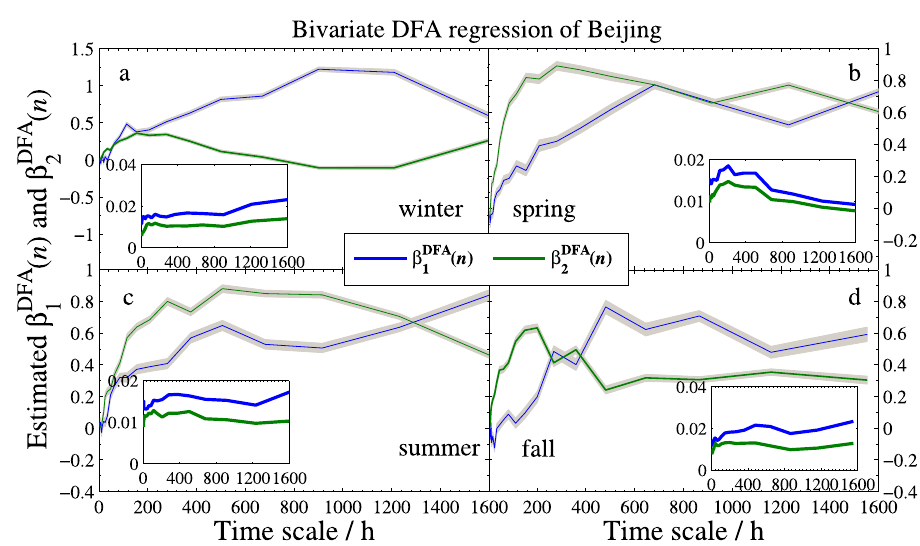
Figure 4. Bivariate DFA regression of Beijing. Main planes of subplots ( a – d ) show estimated DFA regression coefficients β 1 ( n ) and β 2 ( n ) of winter, spring, summer, and fall, respectively. Gray zones denote 95% confidence intervals. Inserts are standard deviations of β